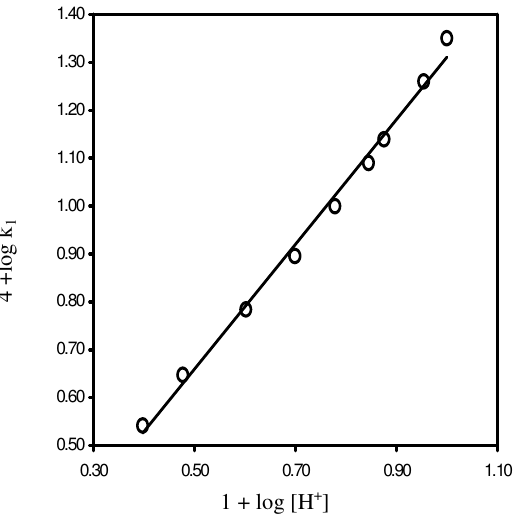
Figure 5. Variation of rate with acid concentration.